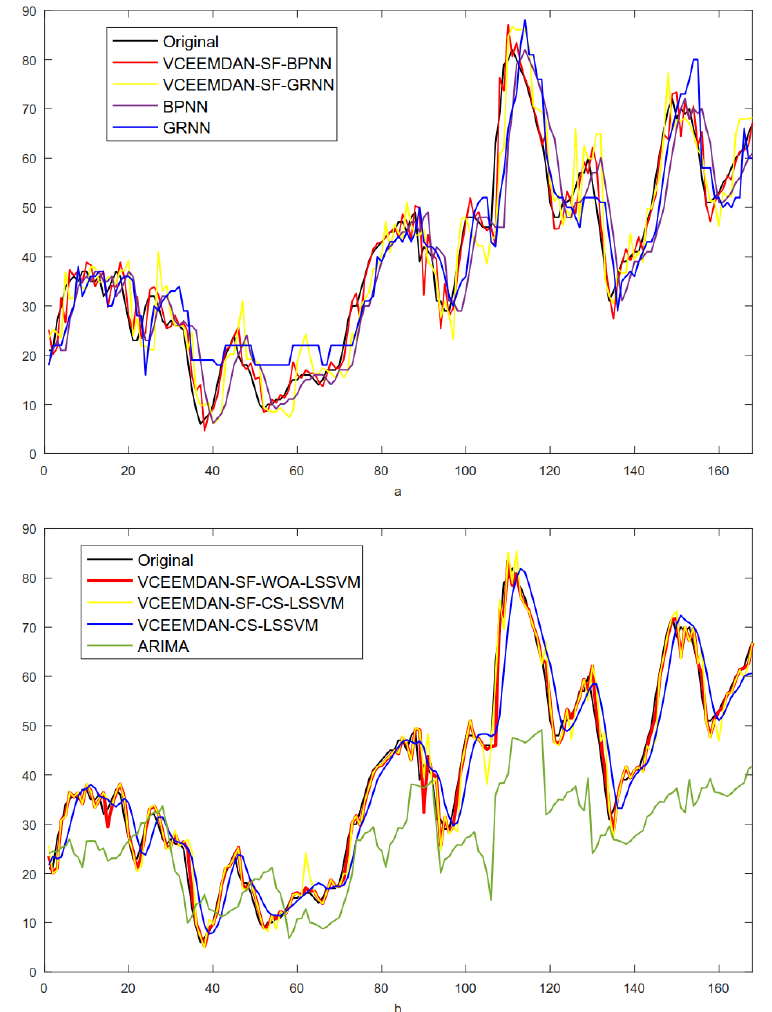
Figure 10. The forecast results in Yibin: ( a ) demonstrate the SF effects on GRNN and BPNN models and ( b ) illustrate the superiorities of SF and WOA in the proposed combined model. Table 8 is the statistical test results of the proposed model and the benchmark